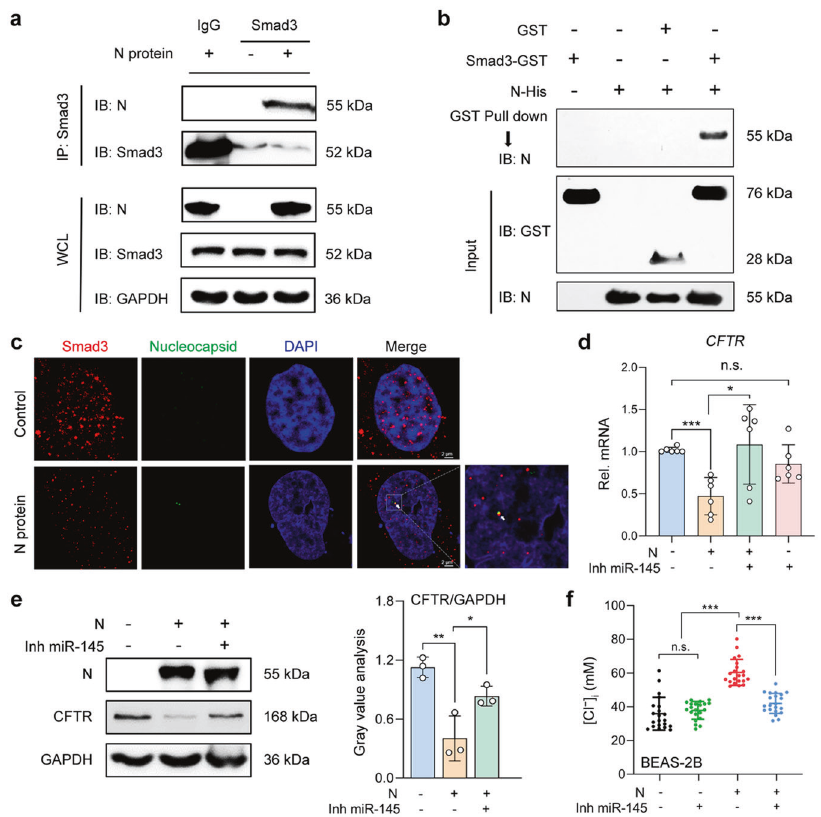
Fig. 3 SARS-CoV-2 N protein interacted with Smad3 to induce miR-145-mediated downregulation of CFTR and increased [Cl − ] i in RECs. a Whole-cell lysates (WCL) from BEAS-2B cells stimulated by N protein (50 μ g/ml) for 24 h were subject to immunoprecipitation with anti- Smad3 beads and immunoblotted with an anti-N protein antibody. b GST pull-down assays using GST-Smad3 and N protein. N proteins binding to GST-Smad3 were detected by using an anti-N protein antibody. c Fluorescence labeling of Smad3 (red) and N protein (green) in BEAS-2B cells with DAPI-labeled nuclei (blue) after stimulation with N protein (50 μ g/ml) for 24 h. Scale bars, 2 μ m. d The effect of Inh miR-145 (100 nM) on the mRNA expression levels of CFTR in BEAS-2B cells stimulated with N protein (50 μ g/ml) for 24 h ( n = 3). e The effect of Inh miR- 145 (100 nM) on the expression of CFTR in BEAS-2B cells stimulated by N protein (50 μ g/ml) for 24 h, with the gray value analysis ( n = 3). f The effect of Inh miR-145 (100 nM) on [Cl − ] i of BEAS-2B cells stimulated by N protein (50 μ g/ml) for 24 h ( n = 20 cells). Data are shown as mean ± SD, * P < 0.05, ** P < 0.01, *** P < 0.001, n.s. P >